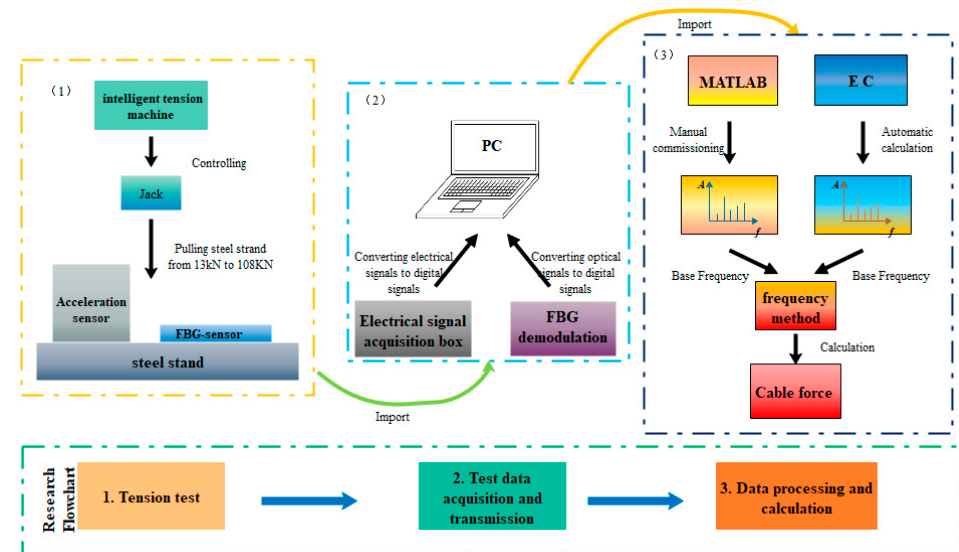
Figure 7. Schematic diagram.